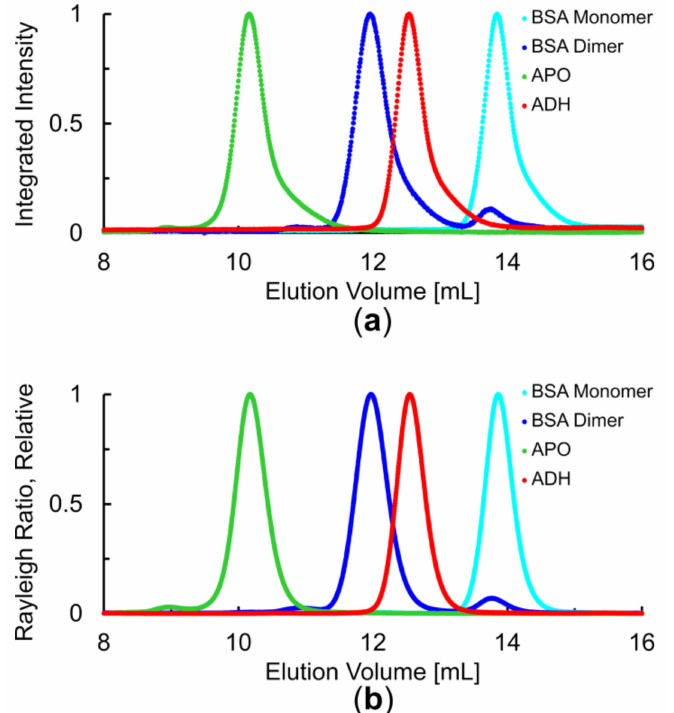
Figure 3. Overlaid elution profiles of indicated samples from Superdex 200 increase 10 / 300 column at 0.5 mL / min collected in SEC-SAXS / MALLS mode. ( a ) SAXS-derived chromatogram—integrated intensities (0.1 nm − 1 < s < 0.8 nm − 1 ) vs. elution volume. ( b ) MALLS-derived